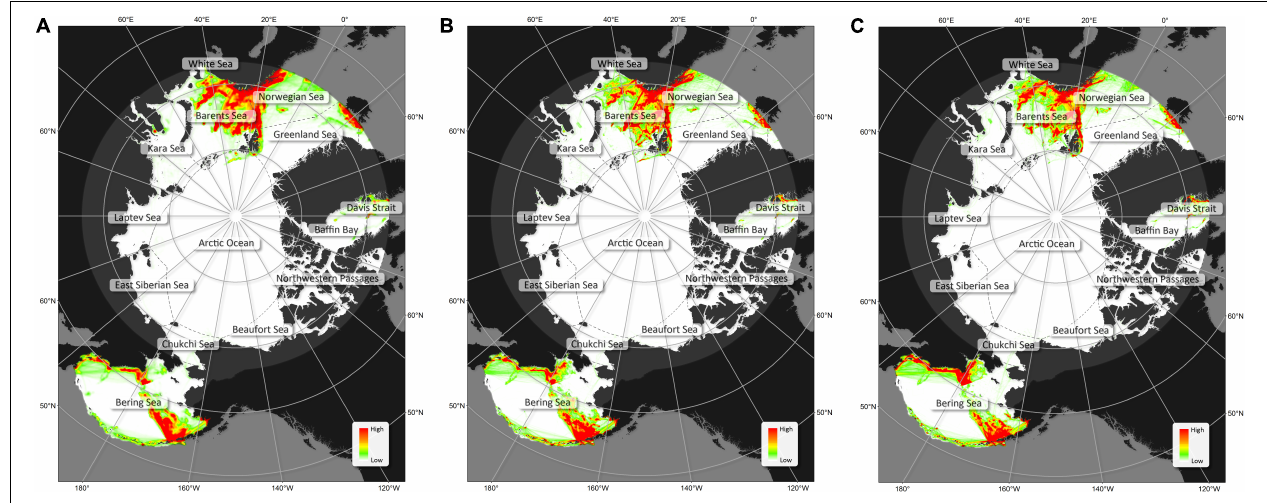
FIGURE 4 | Relative track densities of fishing vessels in (A) 2015, (B) 2016, and (C) 2017. Areas with no color indicate no vessel traffic or low traffic volumes relative to other